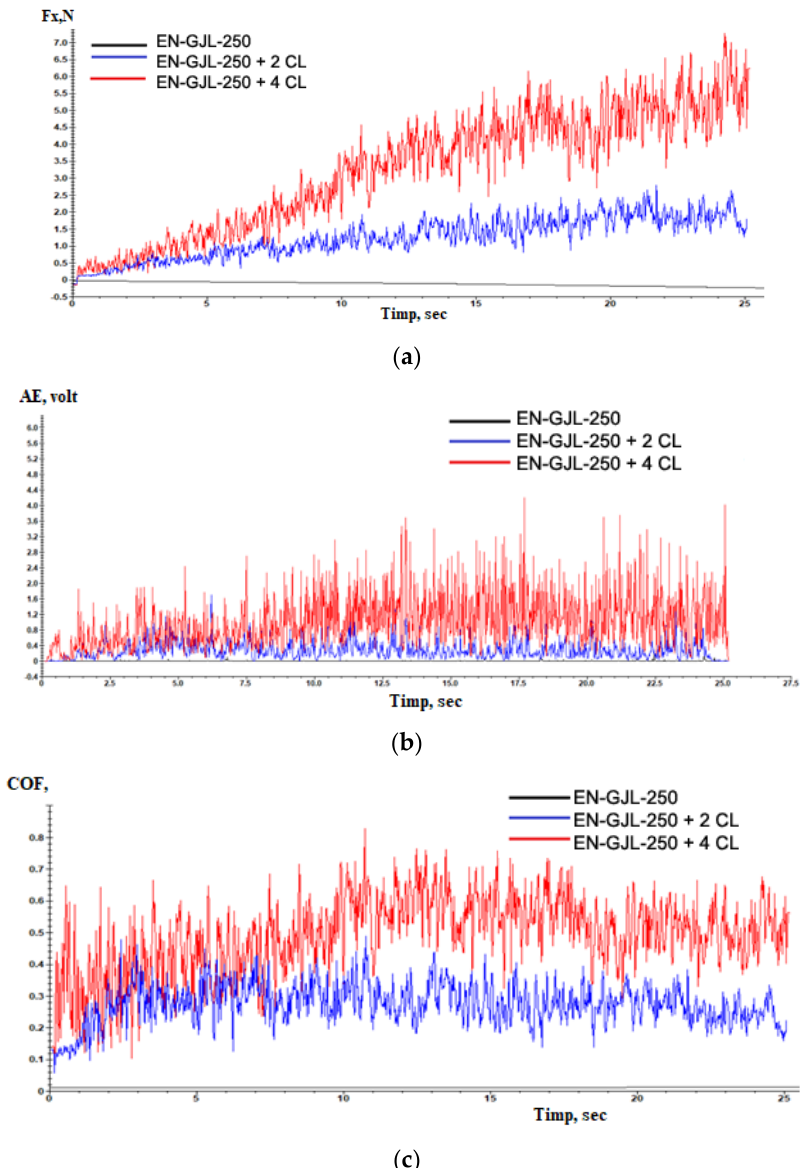
Figure 7. The behaviour of experimental materials EN-GJL-250, EN-GJL-250 + 2 ceramic layers and EN-GJL-250 + 4 ceramic layers at scratching: ( a ) friction force, ( b ) acoustic emission and ( c ) coefficient of friction.